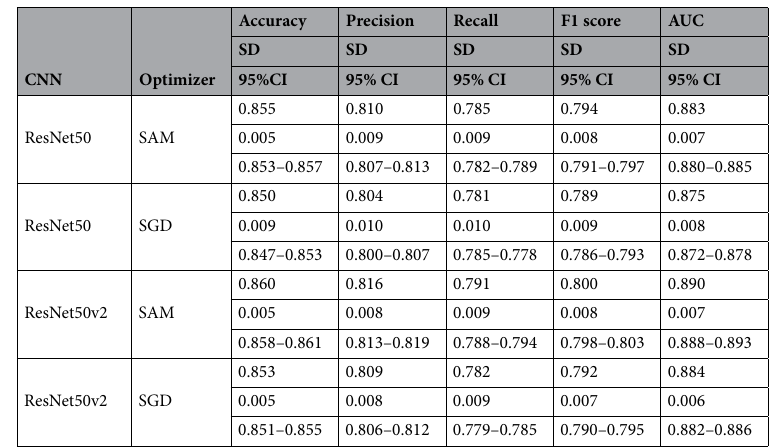
Table 1. Performance metrics of ResNet50 and ResNet50v2 with the SAM and SGD optimizers in contact analysis. SD, standard deviation; 95% CI, 95% confidence interval; AUC, area under the receiver operating characteristics